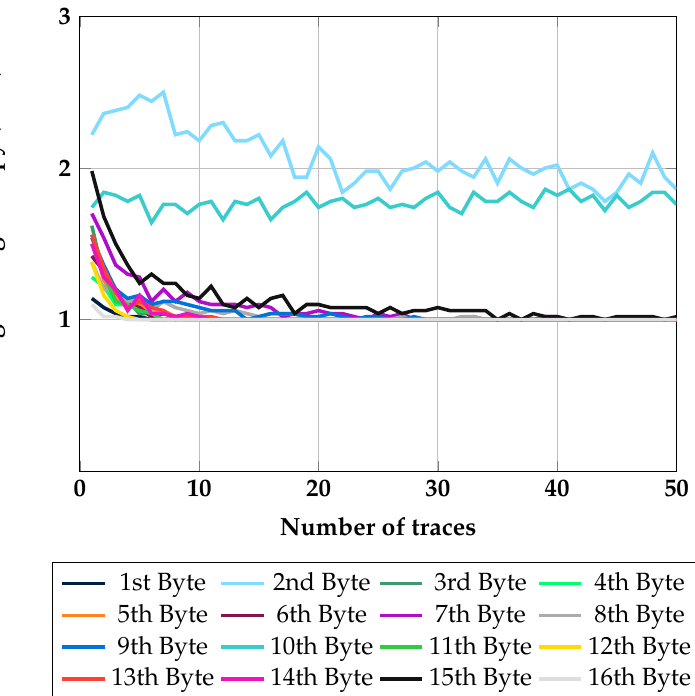
Figure 4. Results for a classical template-based SPA when loading plaintext in block cipher AES with no